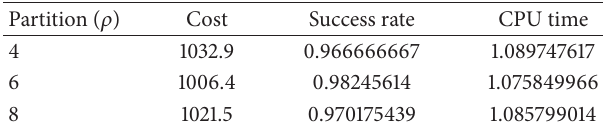
Table 2: The results obtained by different partition granularities ( 𝜌 ) when 𝛼 = 1.01 .